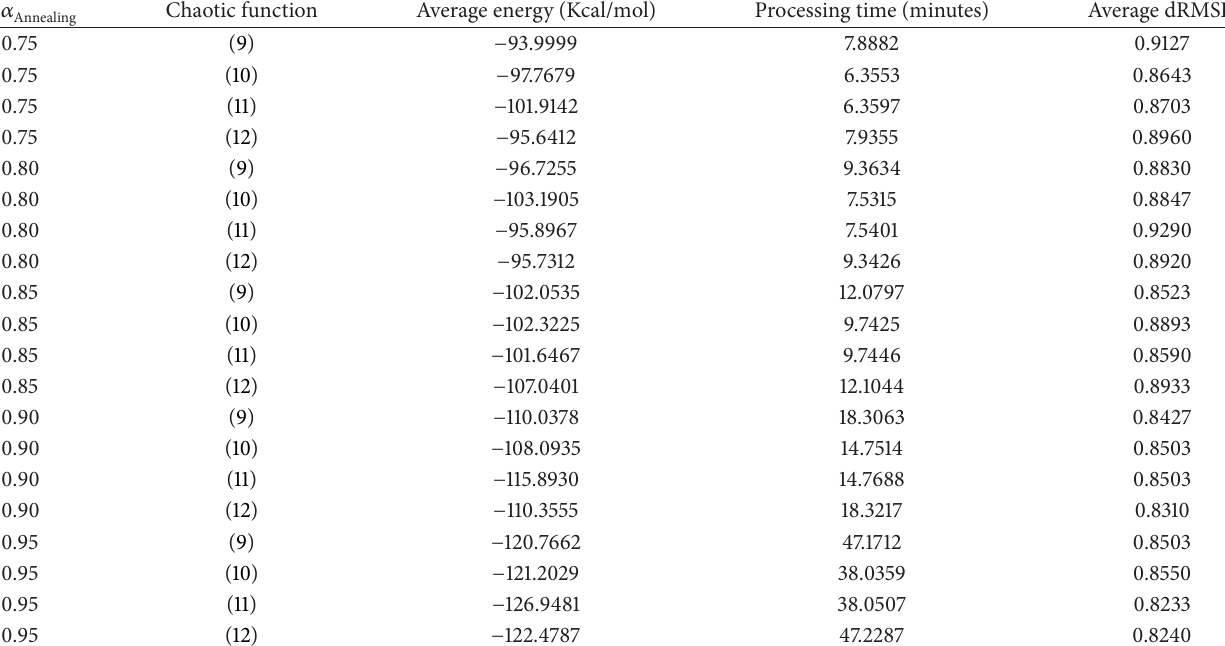
Table 3: Average results of